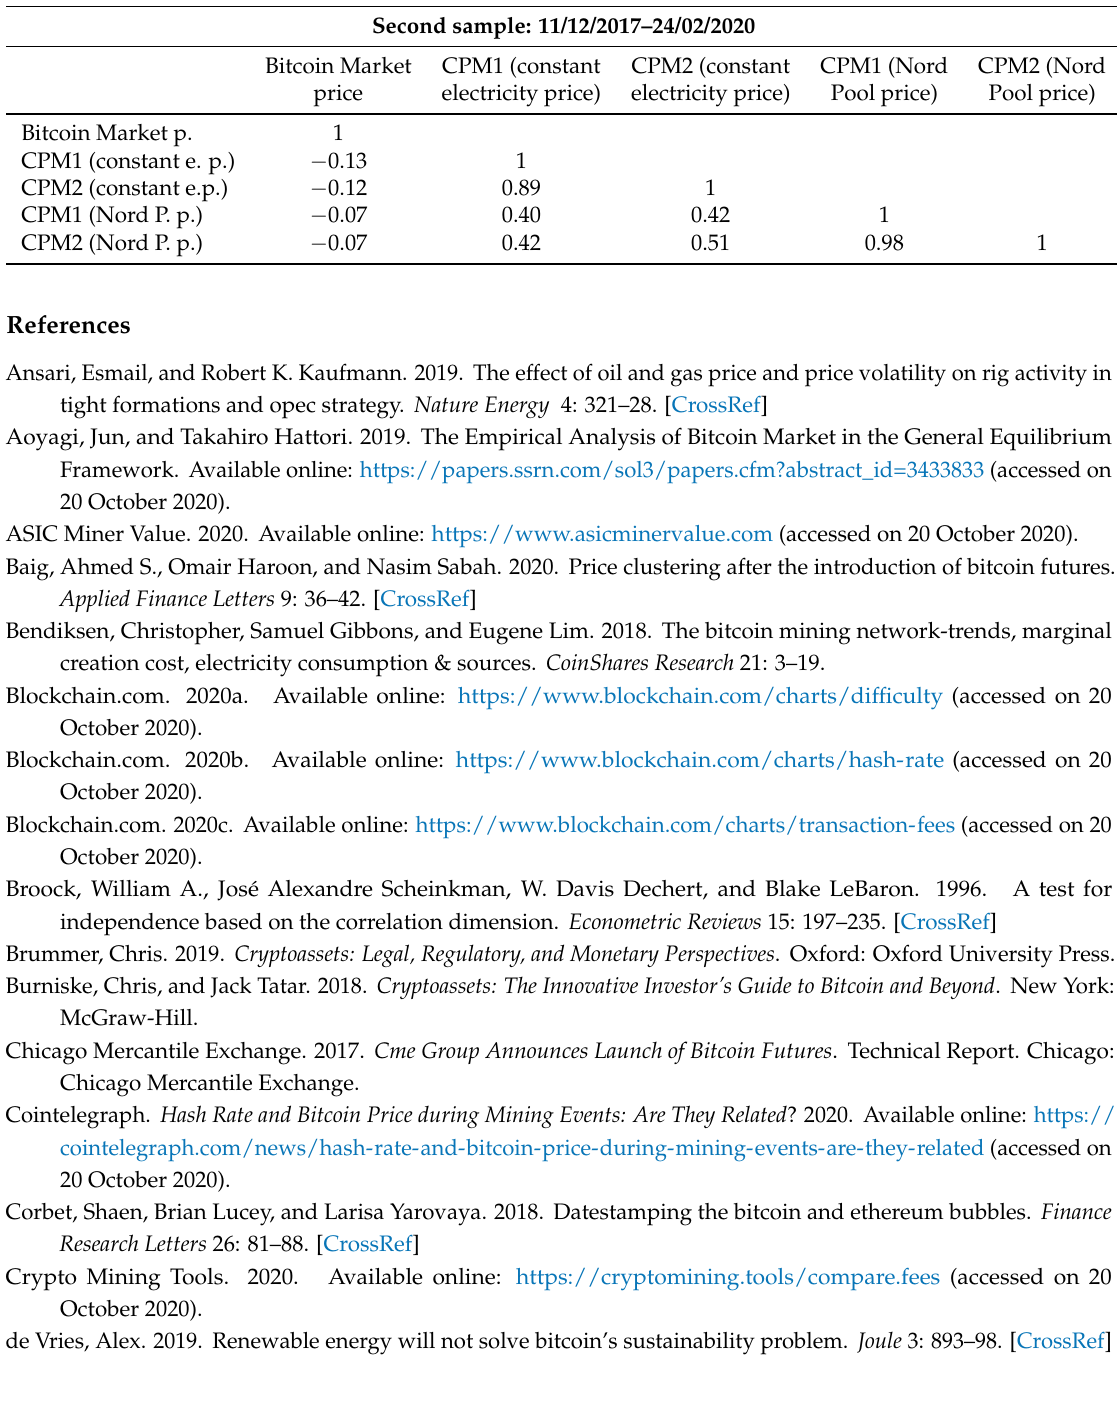
Bitcoin Market p. 1 CPM1 (constant e. p.) CPM2 (constant e.p.) CPM1 (Nord P. p.) CPM2 (Nord P. p.)